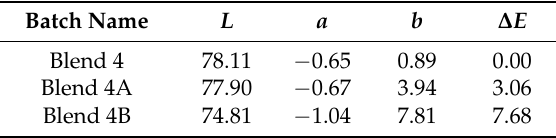
Table 4. Colorimetric data obtained for selected batches.